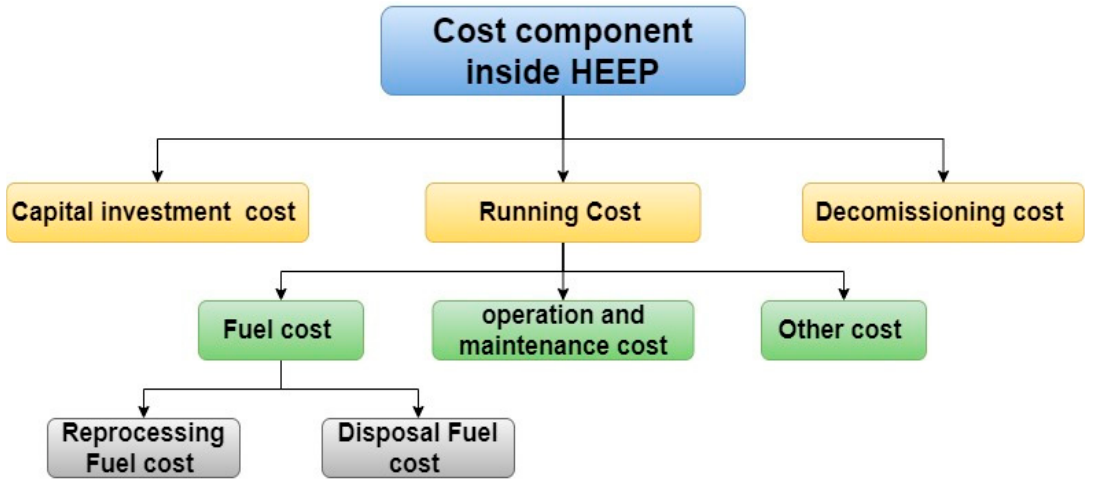
Figure 1. The cost components considered in HEEP.